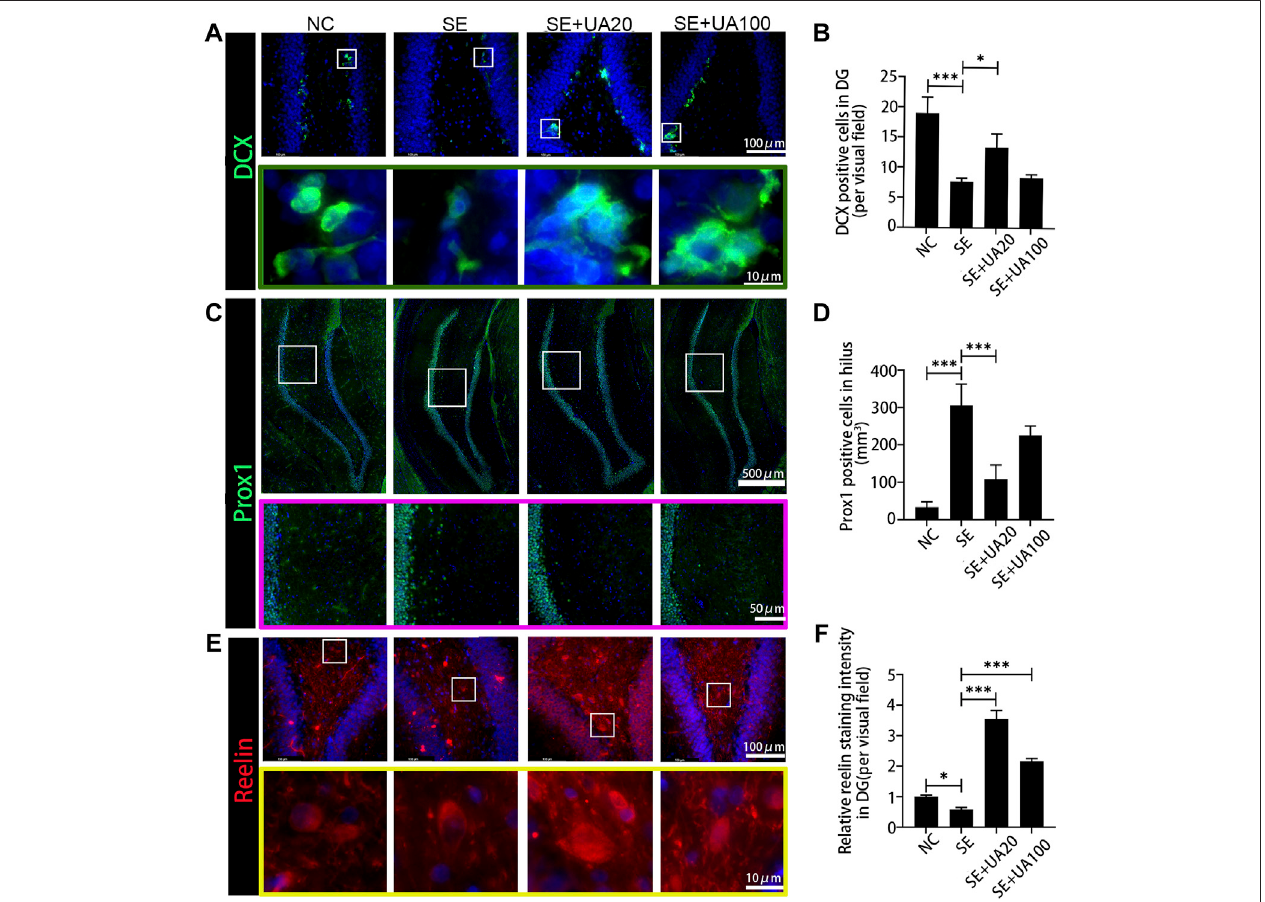
FIGURE 5 | UA enhanced the neurogenesis and attenuated the ectopic migration 10 weeks after SE induction. (A) The immuno fl uorescence staining for DCX + (green)intheDGarea.NucleiwerecounterstainedwithDAPI(blue). (B) NumberofDCX + cellsintheDGarea. (C) Granulecellswereimmunolabeledwiththegranulecell- speci fi c marker Prox1 (green) in the DG area. Nuclei were counterstained with DAPI (blue). (D) Number of Prox1 + cells in hilus. (E) The immuno fl uorescence staining for reelin + interneurons(red)intheDGarea.NucleiwerecounterstainedwithDAPI(blue). (F) RelativestainingintensityofReelininDGareaofthehippocampusafterSE induction (three rats per group, all values are expressed as means ±SD, ppp p < 0.001, p p < 0.05 vs . SE, one-way